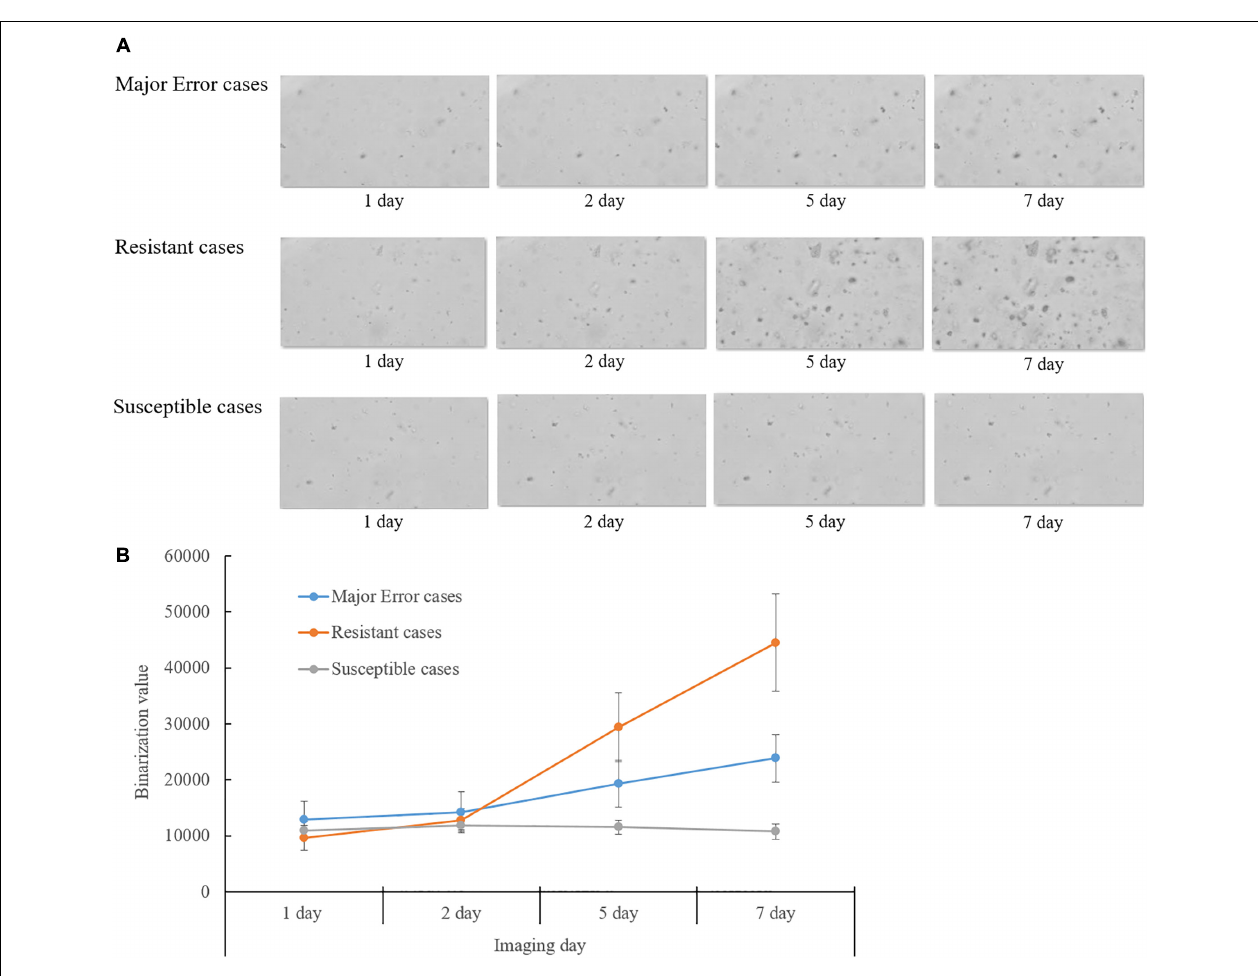
FIGURE 2 | Analysis of QMAC-DST images of isolates showing major error of rifampin DST compared to resistant and susceptible isolates. (A) Colony growth of major error cases was greater than susceptible cases, but clearly lesser than resistant cases. (B) The binarization value denoted cumulative area of colonies. The value of the major error cases was intermediate between resistant and susceptible cases at day five and seven of